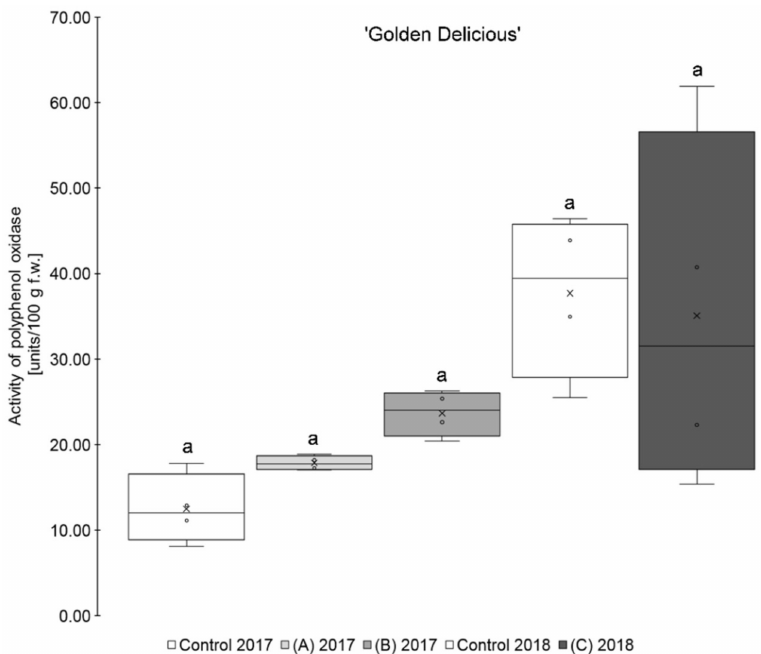
Figure 1. Polyphenol oxidase activity in units / 100 g fresh weight (f.w.) for the apple samples of the variety ‘Golden Delicious’. Foliar Se application per hectare and meter canopy height: 0.15 kg as selenite (A), or selenate (B), 0.075 kg as selenate (C) ( n = 4). Different letters are significantly different ( p <